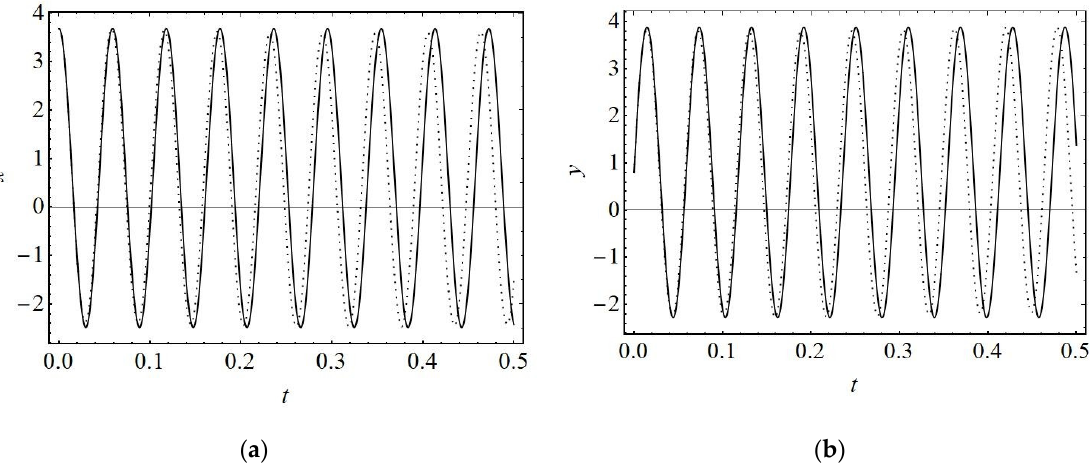
Figure 2. ( a ) x - t and ( b ) y - t diagrams determined analytically (full line) and numerically (dotted line).